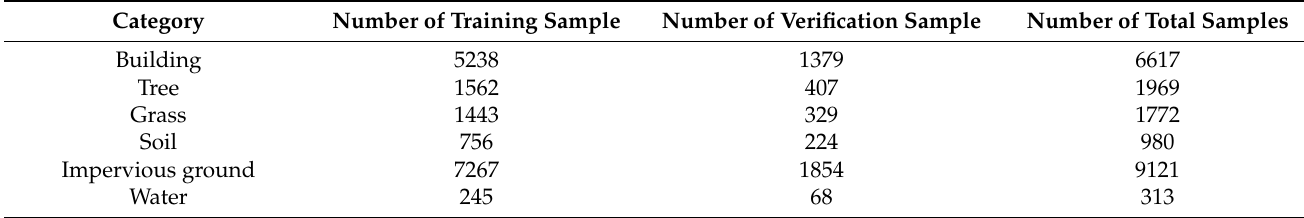
Table 2. Samples selected for the land cover